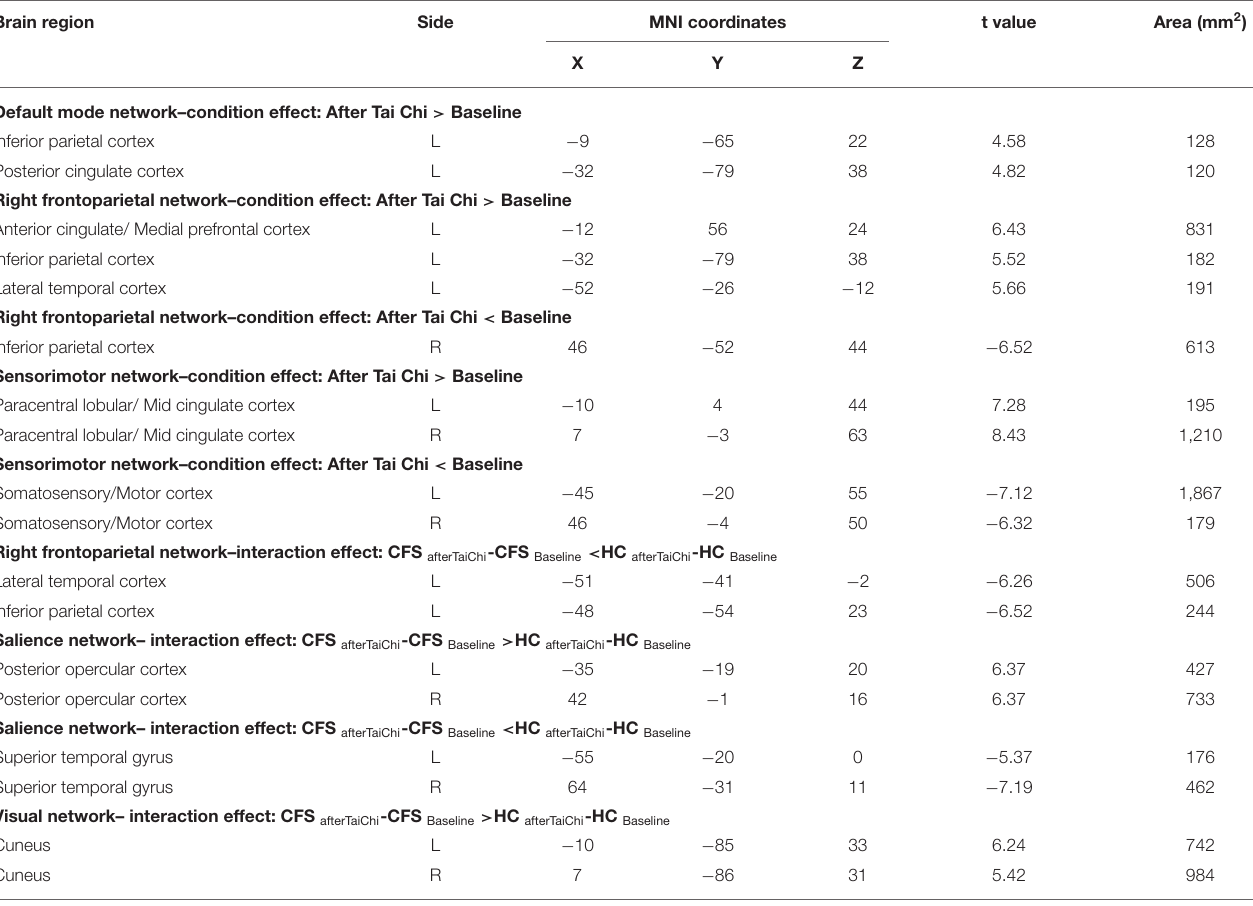
TABLE 3 | The changes of FC in RSNs before and fter Tai Chi Chuan.